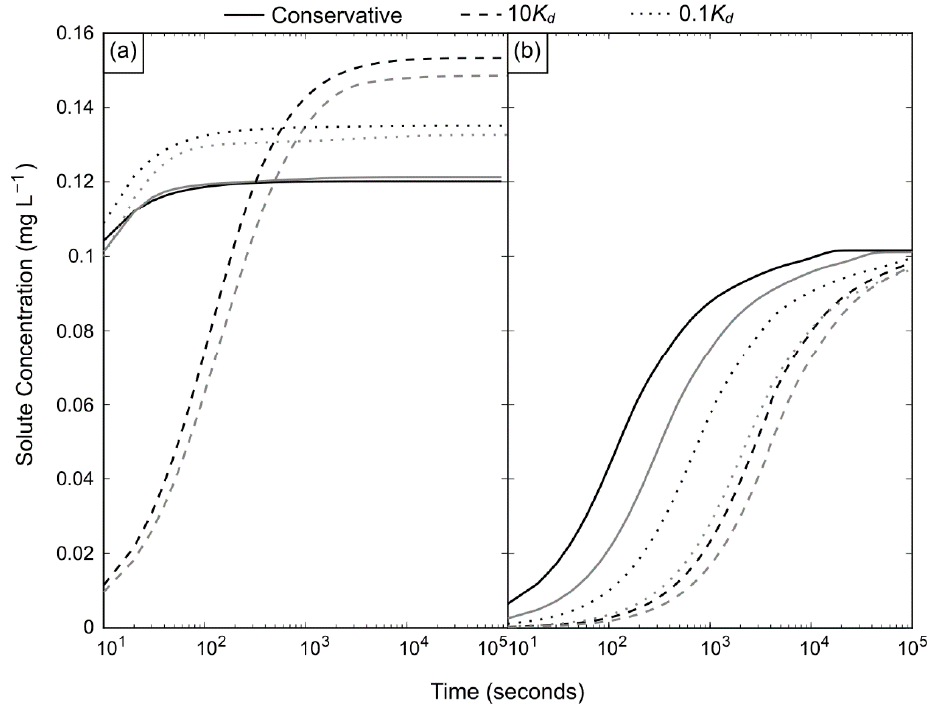
Figure 6. Breakthrough curves for conservative and reactive solutes returned to the stream in ( a ) heterogeneous and ( b ) homogeneous simulations. Black and gray lines indicate percolating and non-percolating sediments, respectively.